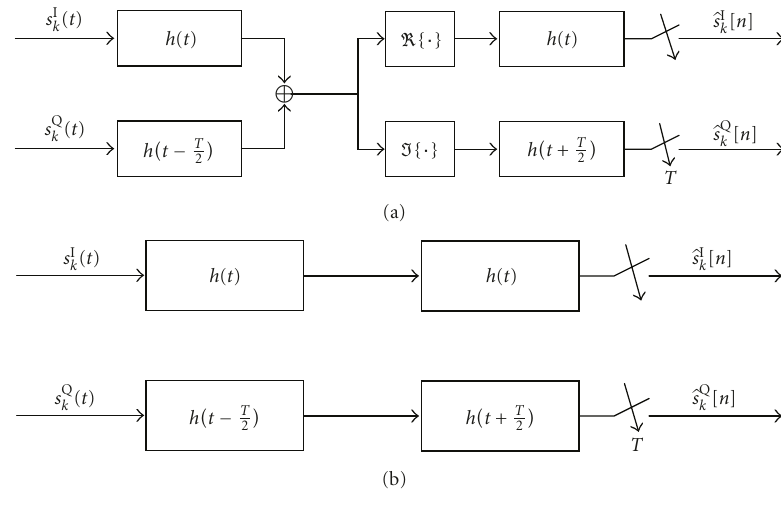
Figure 7: The k th subcarrier channel in an SMT system.